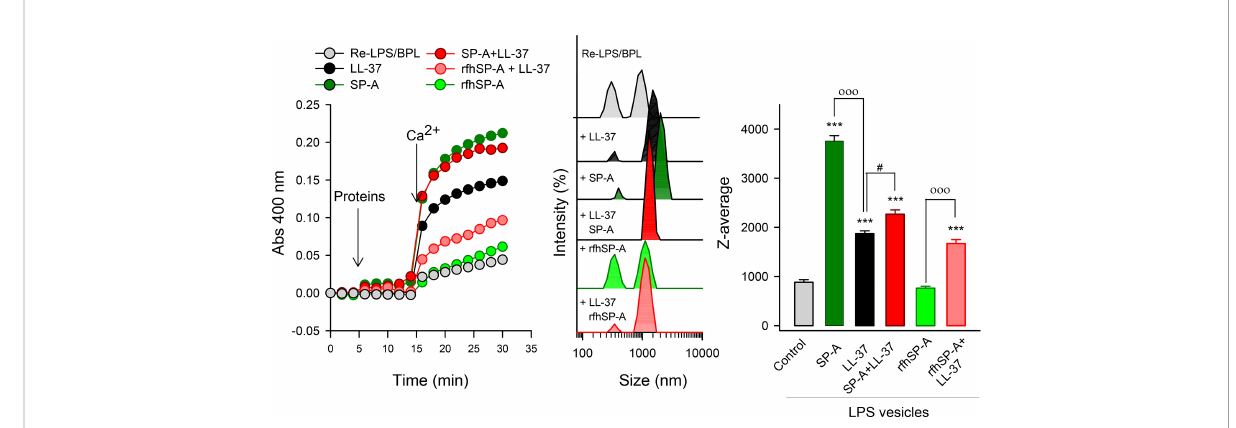
FIGURE 6 Ca 2+ -dependent aggregation of LPS vesicles induced by SP-A, LL-37, rfhSP-A, and combinations thereof. Vesicles mimicking Gram-negative bacterial outer membrane composed of Re-LPS/BPL (8:2, w/w) (50 m g/ml) in 5 mM Tris-HCl buffer, pH 7.4, containing 150 mM NaCl and 0.1 mM EDTA were used. The left panel represent one representative experiment of three of LPS vesicle aggregation measured by turbidity at 400 nm. The central panel shows the samples used for turbidity measurements analyzed by DLS. The right panel shows the Z-average measurements of these samples. Results are the mean ± SD of three experiments. For statistical analysis, ANOVA followed by Bonferroni multiple comparison test was used. ***p < 0.001 when protein-treated samples are compared with the control (LPS vesicles). ooo p < 0.001 when samples with SP-A/LL-37 or rfhSP-A/LL-37 are compared with SP-A- or rfhSPA-samples, respectively. # p < 0.05 when SP-A/LL-37- and LL-37-samples are compared. The concentrations of proteins were 75 nM SP-A, 1.1 µM LL-37, and 0.43 µM rfhSP-A. The concentration of Ca 2+ was 2.5